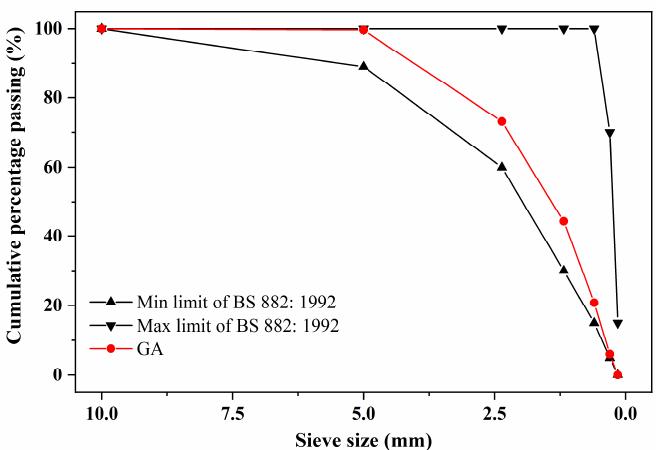
Figure 4. Particle size distribution of GA, conforming to the requirements of British standard BS 882:1992.